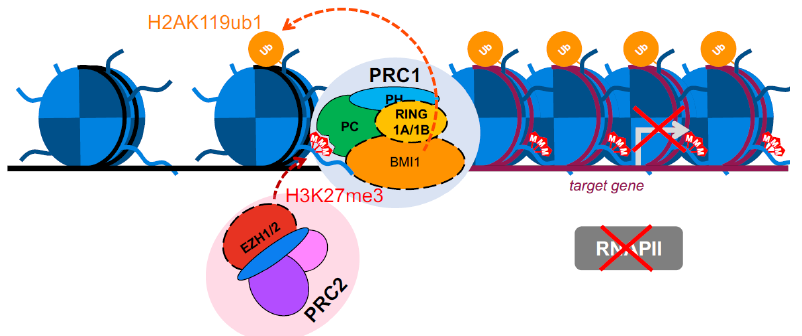
Figure 2. Traditional view of transcriptional repression mediated by PRC1 and PRC2. The enzymatic component of PRC2, EZH1/2, trimethylates histone H3 at lysine 27 (H3K27me3). PRC1 components recognize and bind to this modification and monoubiquitylate histone H2A at lysine 119 (H2AK119ub1). Ultimately, these modifications result in transcriptional repression of the target gene.